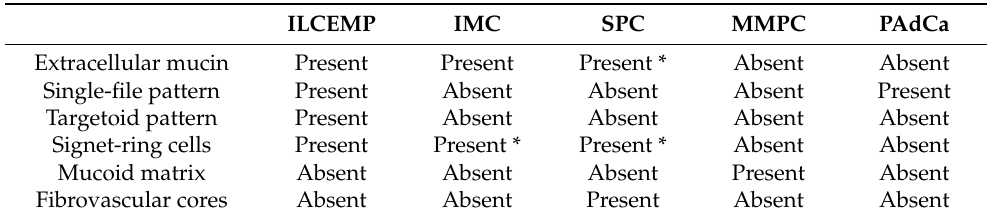
Table 4. Morphological characteristics of invasive lobular carcinoma with extracellular mucin pro- duction and its differential diagnoses.